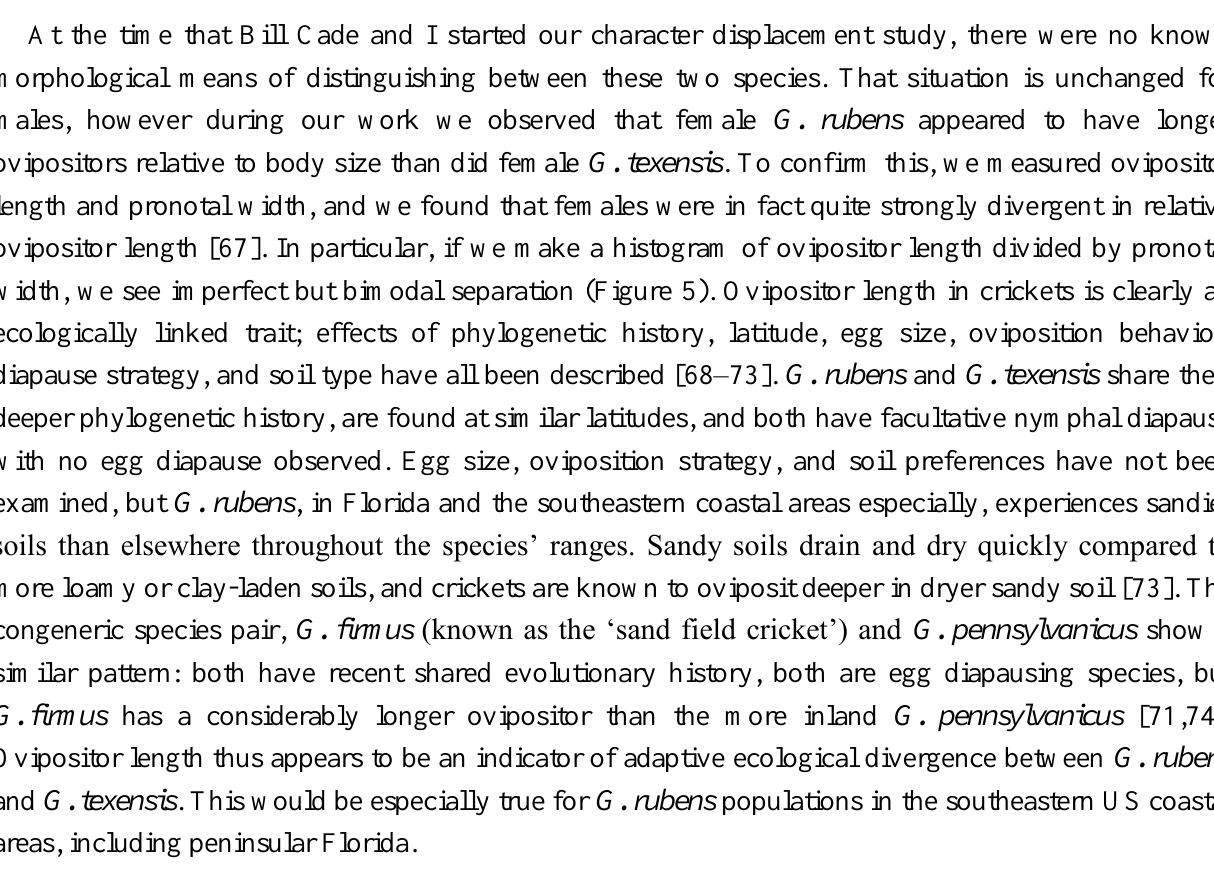
Figure 5. Ovipositor length relative to body size (pronotal width) in